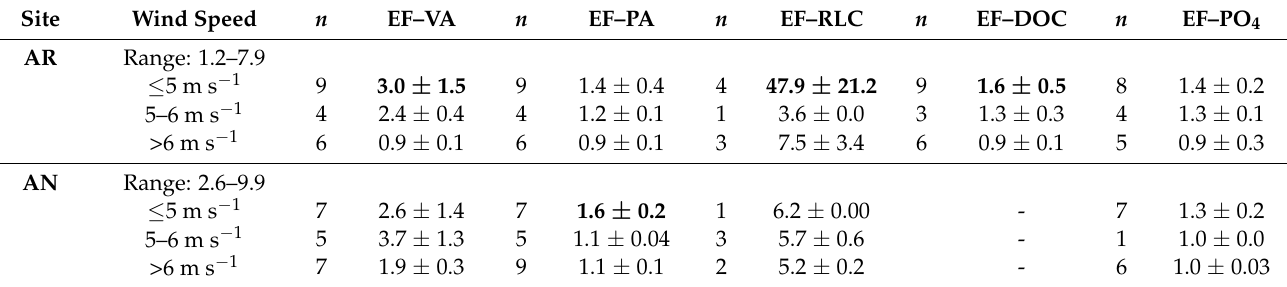
Table 5. Enrichment factor (EF) of abundance of viruses (VA), prokaryotes (PA), rate of lysed cells (RLC), and concentrations of dissolved organic carbon (DOC) and phosphate (PO 4 ) under different wind speeds for both polar systems. Significantly different values (Student’s t -test, p < 0.05) between low ( ≤ 5 m s − 1 ) and high (>6 m s − 1 ) wind speeds are in bold; -: no data. Site AR Range: 1.2–7.9